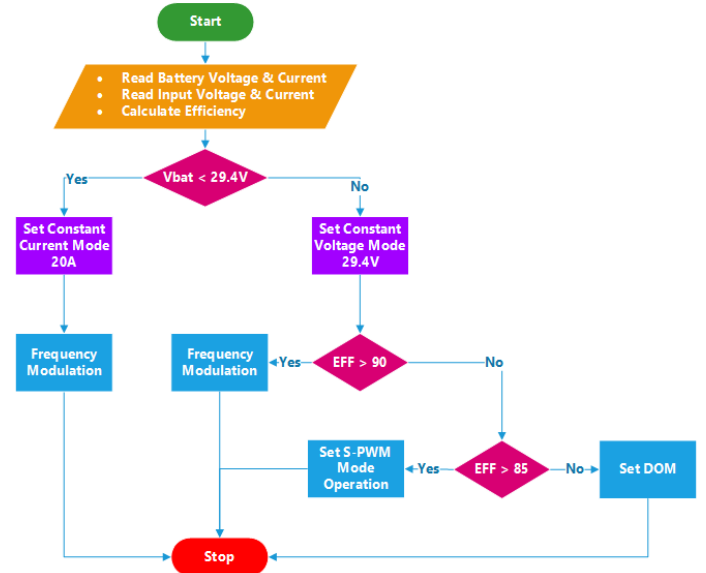
Figure 21. One cycle flowchart of proposed